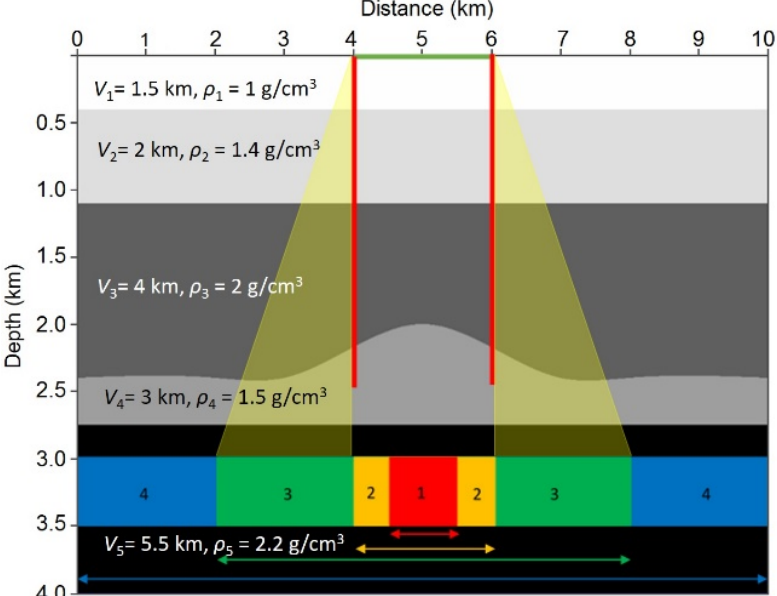
Figure 13. The geological model used in this study. Noise boundary 1 (red) laterally extends from 4500 to 5500 m; noise boundary 2 (yellow) extends from 3000 to 6000 m; noise boundary 3 (green) extends from 2000 to 8000 m; and noise boundary 4 has the same lateral extent as the model. The yellow triangles show the ideal range for the surface geometry that is between 0° and 33° (between noise boundaries 2 and 3).